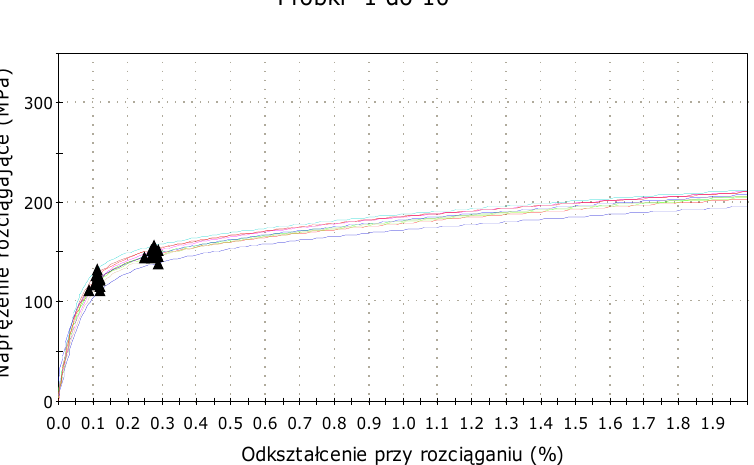
Figure 15. Stress–strain graph for samples with lamination angle 90 ◦ and with envelope.